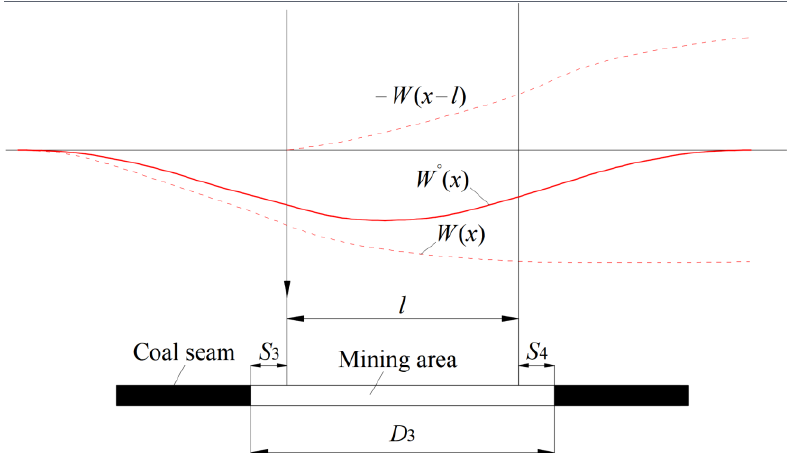
Figure 6. Surface subsidence in the main section of the limited mining strike.